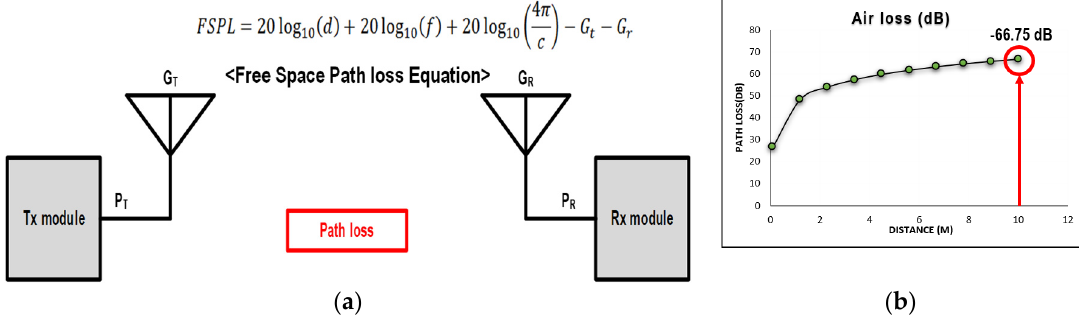
Figure 2. ( a ) System budget and ( b ) path loss measurement vs. distance. Reprint with permission [4775431338148]; 2020, IEEE.